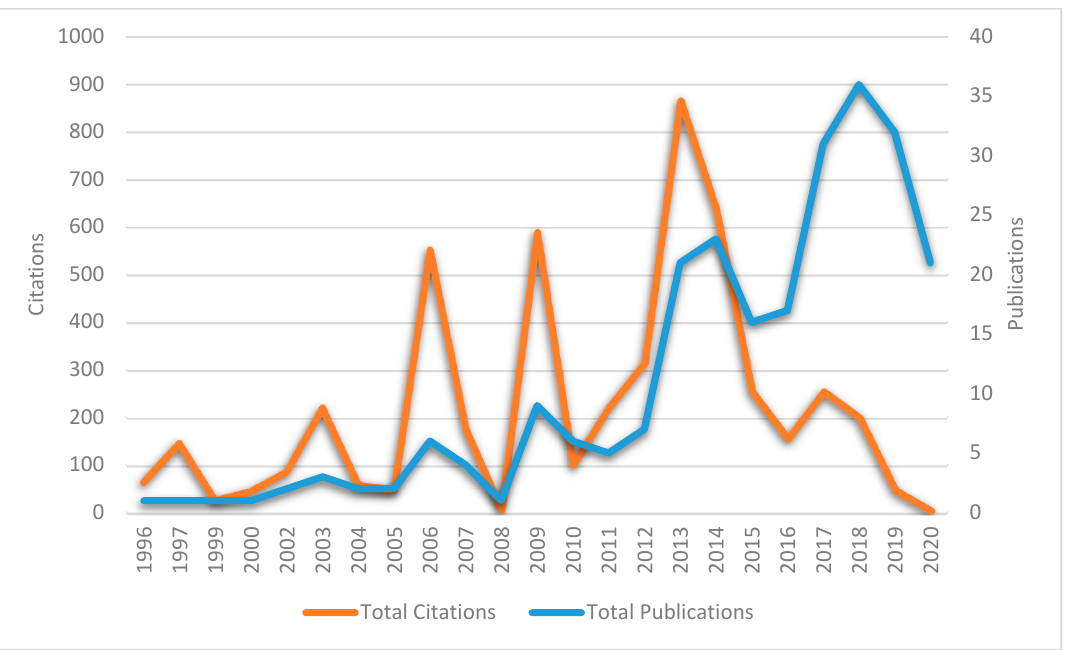
Figure 2. Publishing and citation trends in antibacterial dental adhesive research. Table 1. Most influential countries and organizations in terms of total publications (TP), total